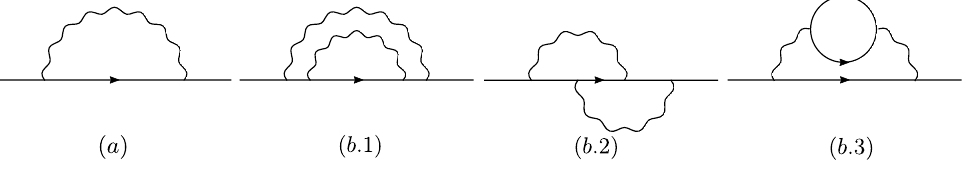
Figure 8 . One loop and two loops diagrams. We sum over all possible insertions of the composite operators on the internal fermion lines, and also on vertices in the case of O 2